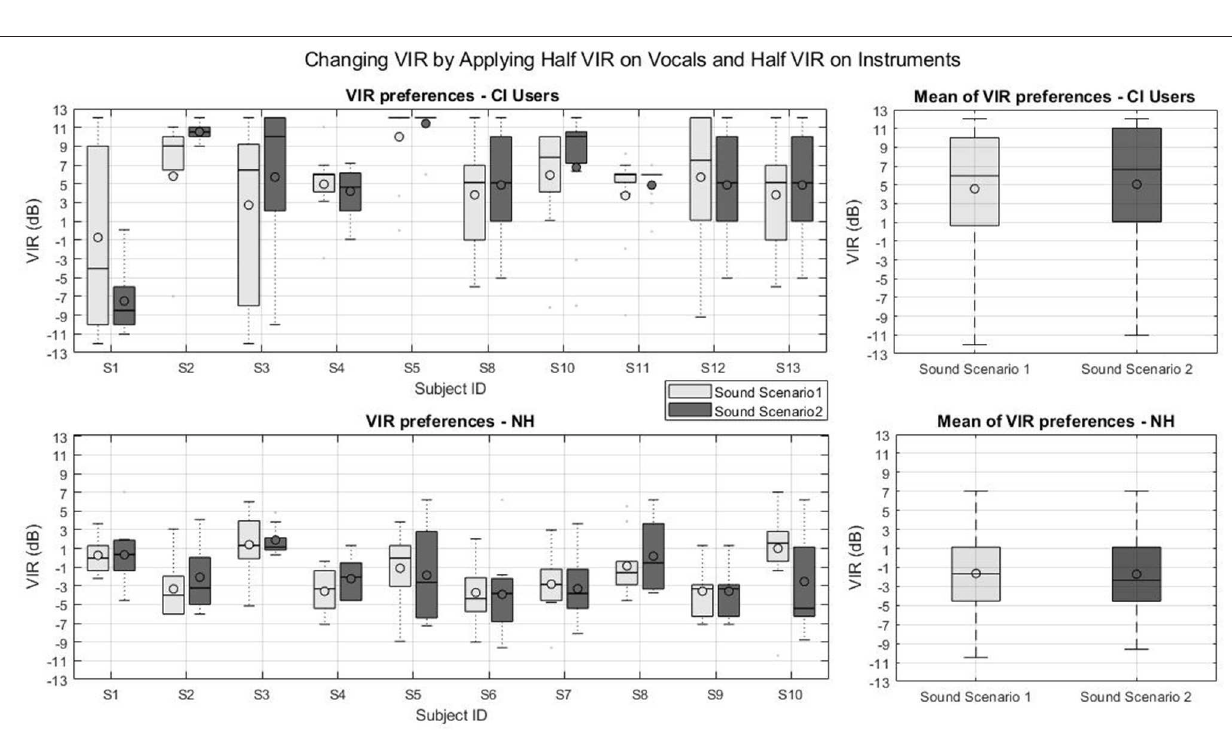
Frontiers in Neuroscience |